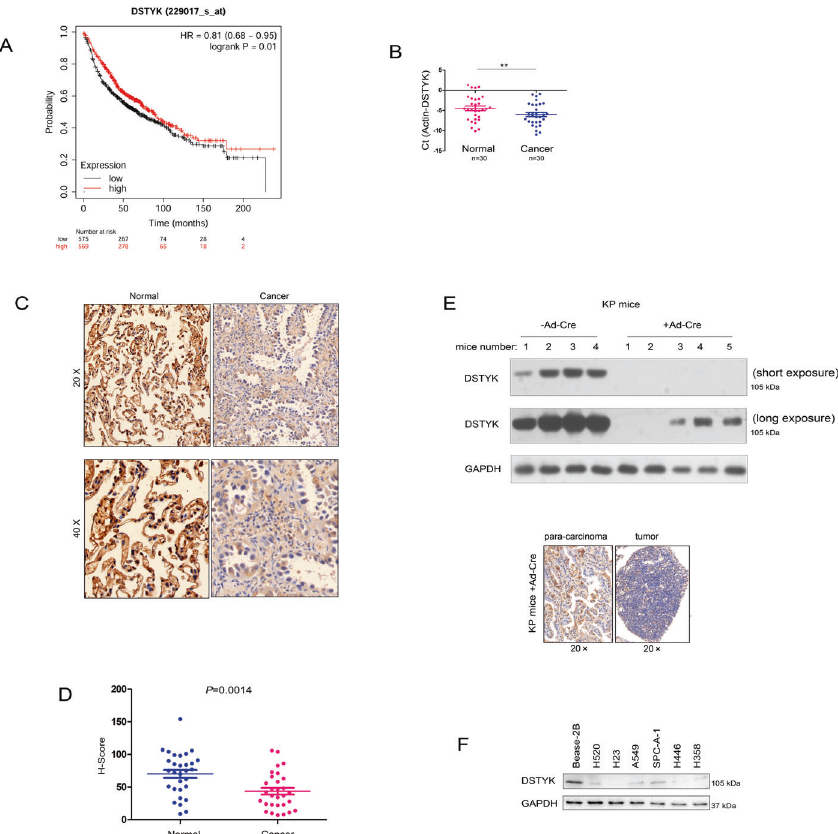
Fig. 1 DSTYK was downregulated in lung cancer. A The KmPlot database was mined to con fi rm the correlation between the expression of DSTYK and the survival of patients with lung cancer. B qPCR was performed to determine the mRNA levels of DSTYK in lung cancer tissues and noncancerous tissues. ** P < 0.01. C Immunohistochemistry (IHC) was performed to determine the protein levels of DSTYK in lung cancer tissues and noncancerous tissues. The images with different magni fi cation were shown and the scale bar was indicated. D Statistical analysis of the data in C . The IHC intensity was scored and analyzed. E Western blot and IHC were performed to determine the protein levels of DSTYK in the KP mouse model. Eight-week-old KP mice in the experimental group were treated with Ad-Cre virus ( + Ad-Cre) (10 9 per mouse) to delete the expression of P53 and activate the expression of Kras G12D . Mice in the control group were treated with control virus. Twelve weeks later, the mice were killed, lung tissues were collected, and DSTYK protein levels were examined by western blot (up) and IHC (below). The images of western blot with long exposure and short exposure were shown. F The protein levels of DSTYK in normal lung epithelial cells (Bease-2B) and lung cancer